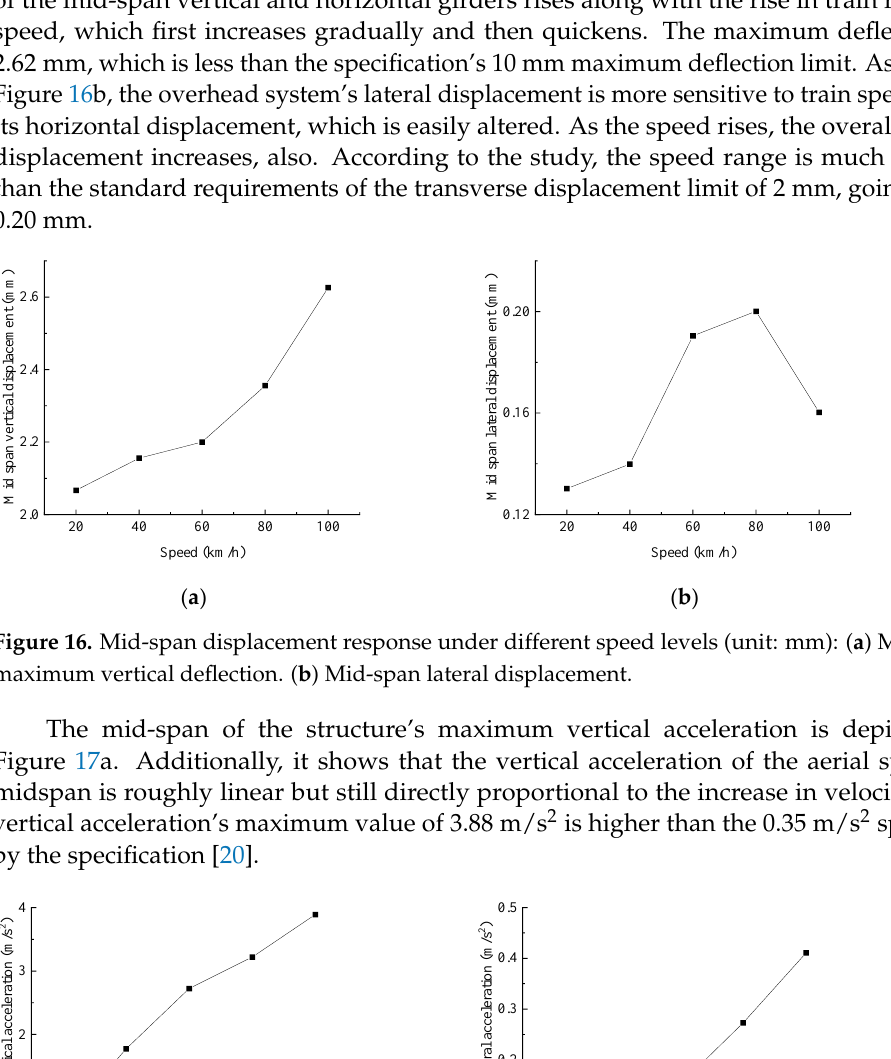
Figure 17. Mid-span acceleration response under different speed levels (unit: m/s 2 ): ( a ) Mid-span vertical acceleration. ( b ) Mid-span lateral acceleration.